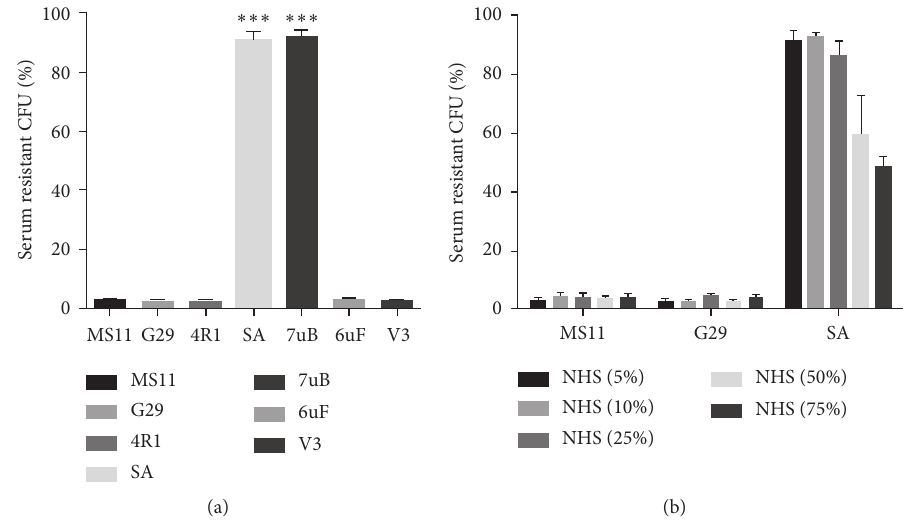
Figure 5: Serum resistance levels of the input and reisolated strains were assayed at different concentrations of the NHS. Bacterial suspensions were allowed to coincubate with the NHS for 60 min, and control assays were performed identically with heat-inactivated serum (56 ° C for 30min). The serum resistance of the input strain and reisolates were assayed for their resistance levels at different concentrations of NHS (10% for (a); 5%–75% for (b)). All of the experiments were performed in triplicate. ∗∗∗ p < 0 .